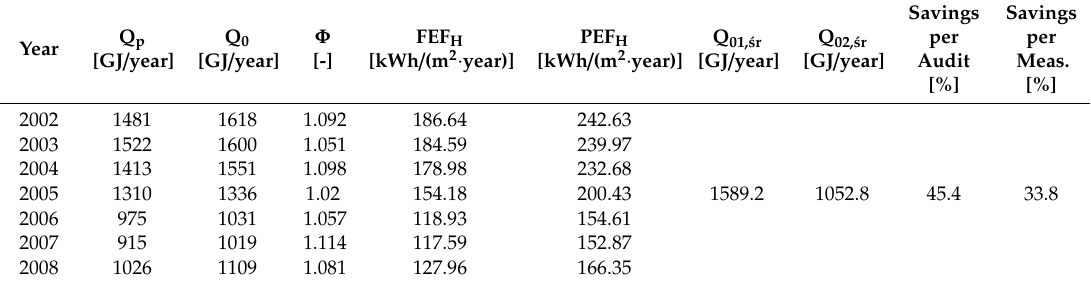
Table 6. Characteristics and heat consumption of an object from the group G4.